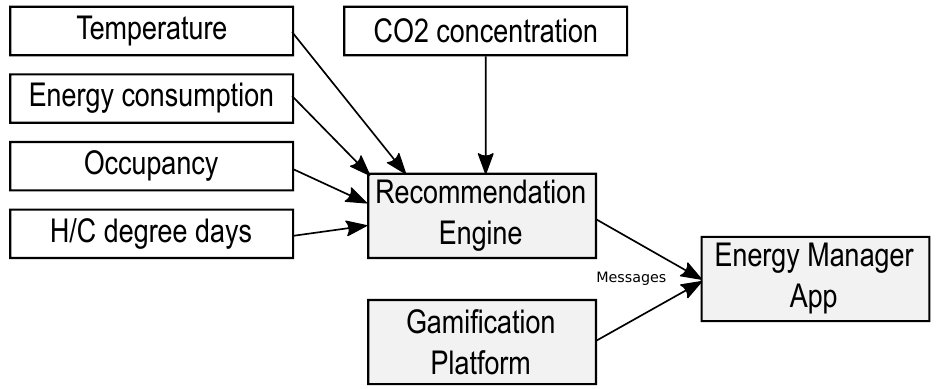
Figure 22. Block scheme of the energy management